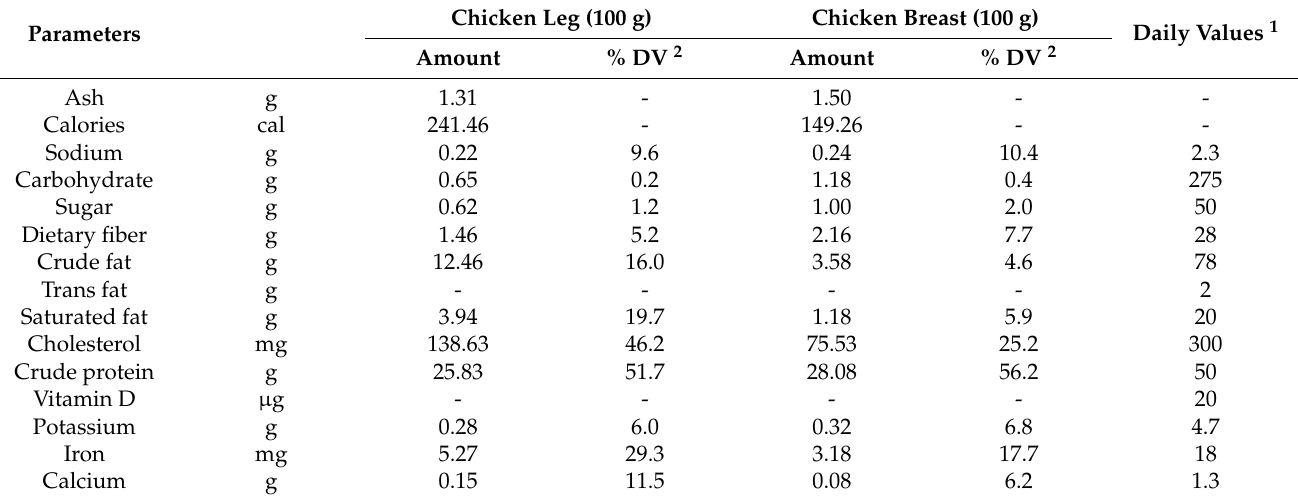
Table 6. Nutritional values of processed chicken leg and